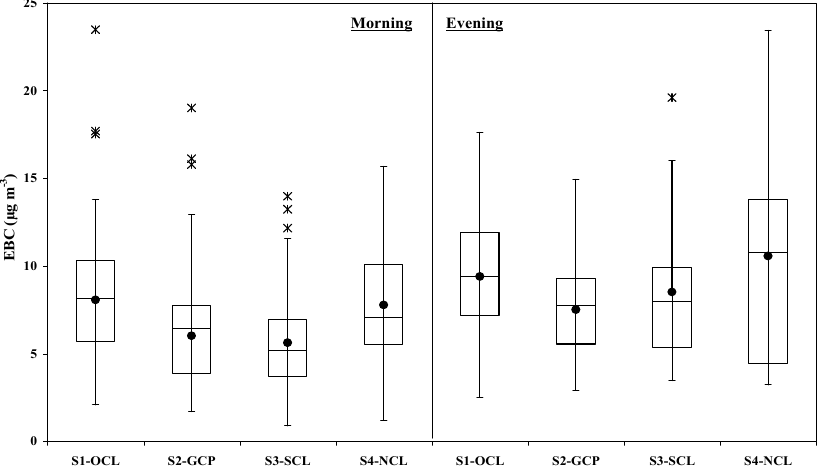
Figure 4. Box-plots of 1-min concentration data for EBC in the cold season (mean values: dots; min-max range: whiskers: median and interquartile range: boxes).